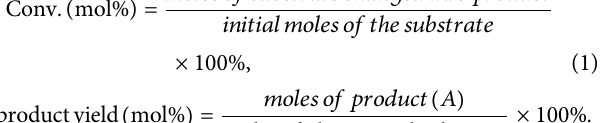
FIGURE 1 | Effect of ratio of metal loads on GUA conversion and the main product yield. Reaction conditions: 1 g GUA, 0.5 of Ni – Mn/Nb 2 O 5